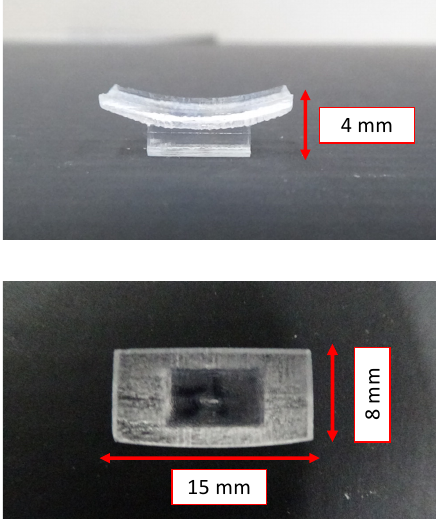
Figure 5. Overview of the variable-focus